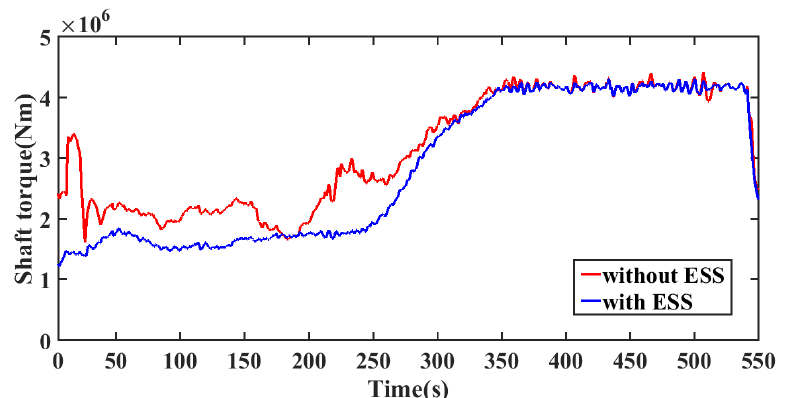
Figure 13. Shaft torque of WT 4.